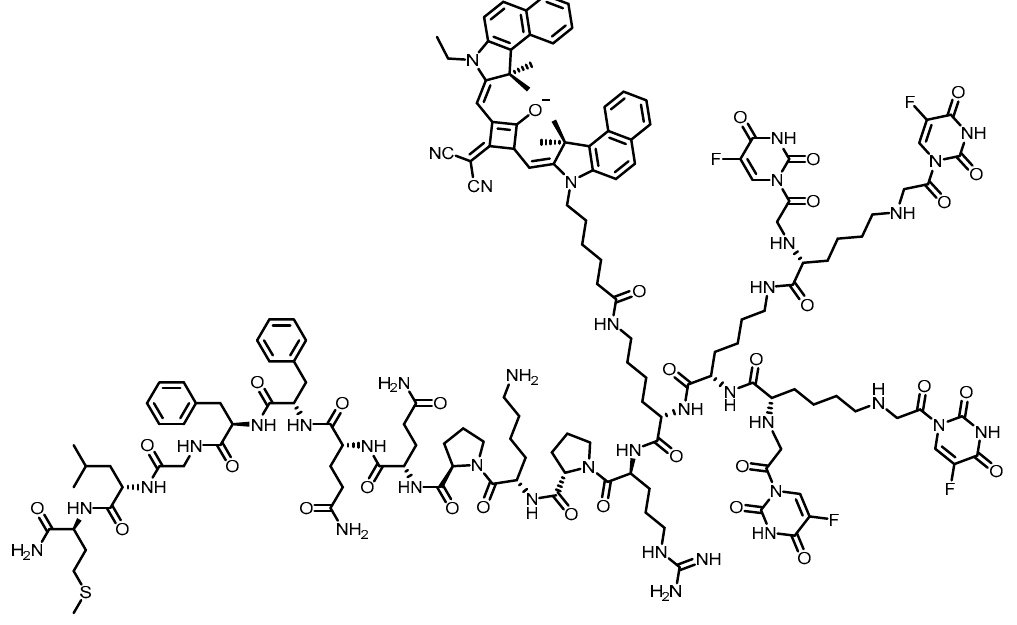
Figure 5. SP dendron containing branches conjugated to 5-FU for brain targeting [49].